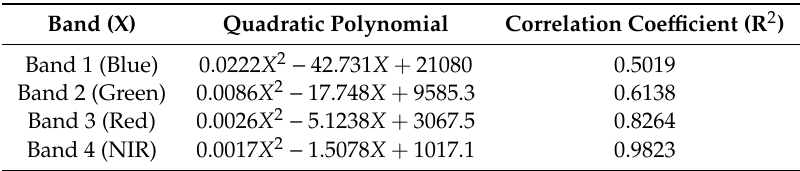
Table 3. Fitting quadratic polynomial and the correlation coe ffi cient of the SSC and the remote sensing